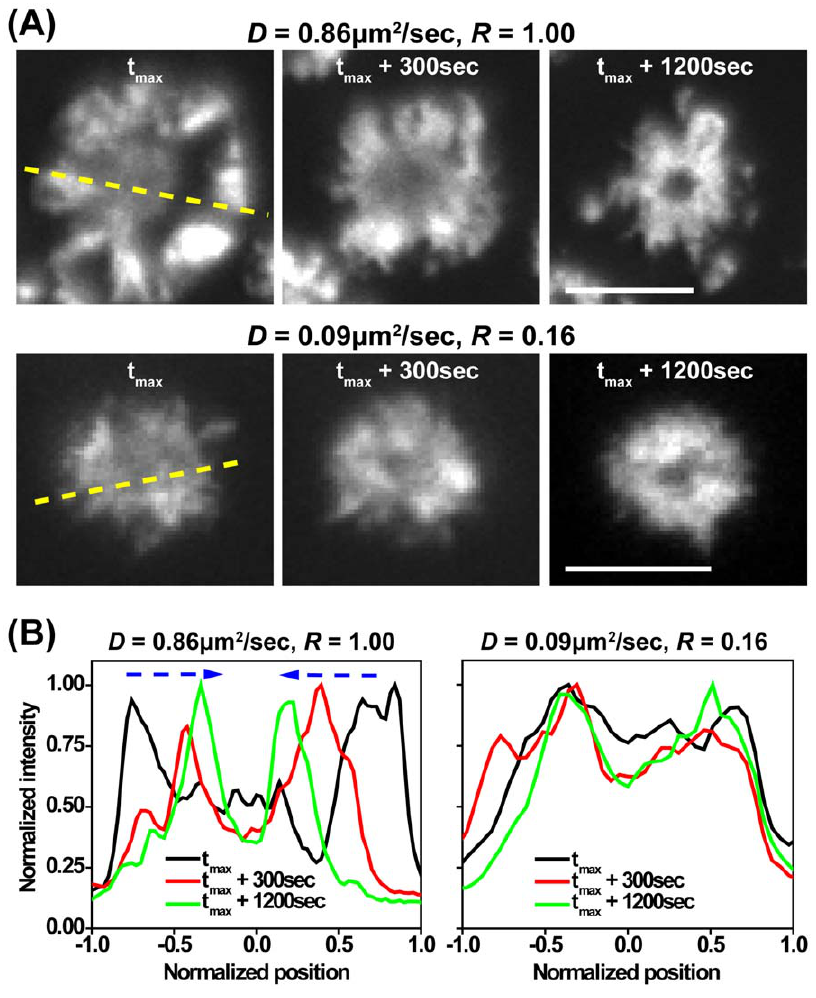
Figure 5. Actin contraction is altered by ligand mobility. (A) Representative time-lapse TIRF images of GFP-actin expressing Jurkat cells stimulated on surfaces with the indicated D and R . The time when cells exhibit the maximum actin spreading was defined as t max . Scale bars=10 m m. (B) Corresponding normalized actin fluorescence intensities at t max (black), t max + 300 sec (red), and t max + 1200 sec along the dashed lines in (A).